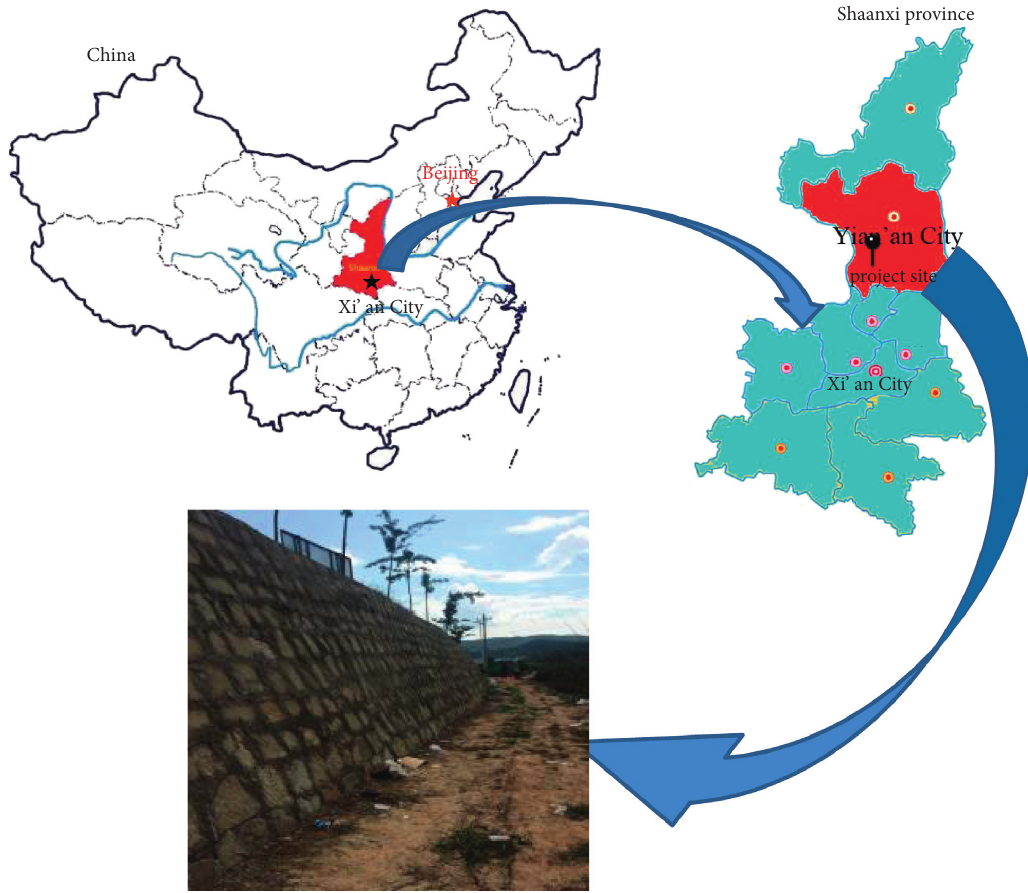
Figure 1: Slope prototype location in China.